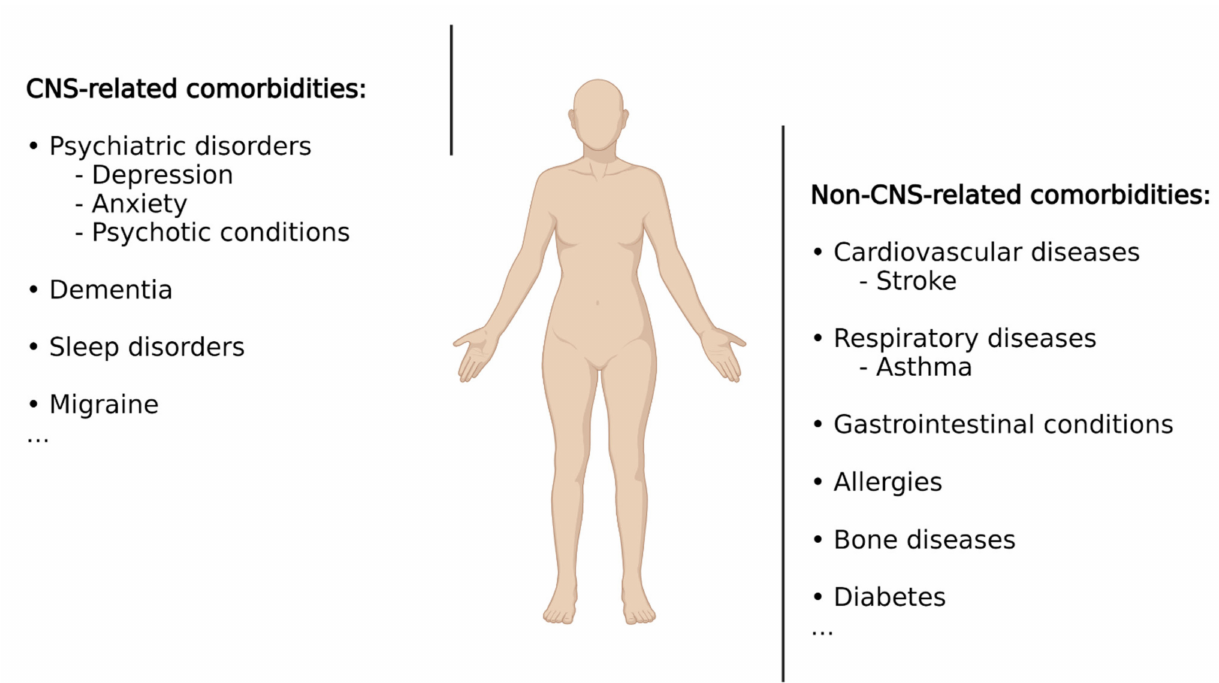
Figure 1. Epilepsy-associated co-morbidities. Schematic representation showing the most common comorbidities associated with epilepsy including CNS- and non-CNS-related conditions. Created with BioRender.com (accessed on 17 February